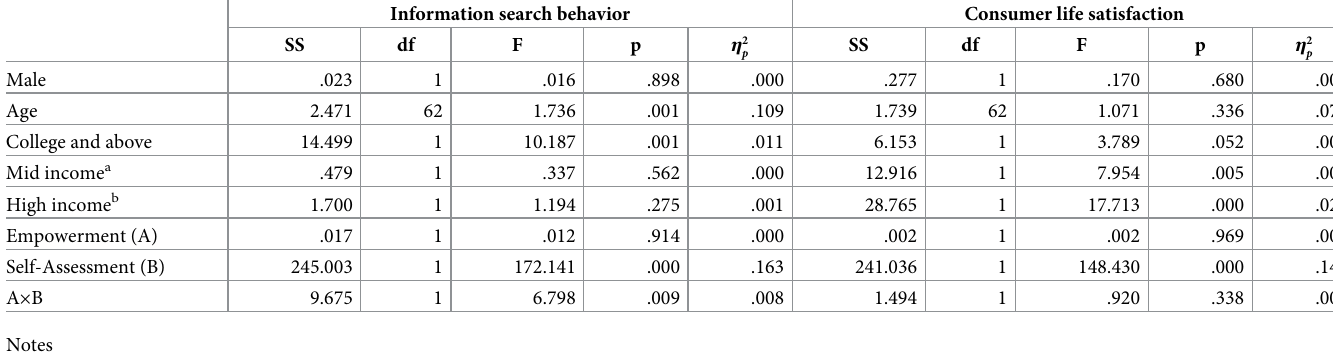
Table 4. Effects of empowerment and self-assessment on information search behavior and consumer life